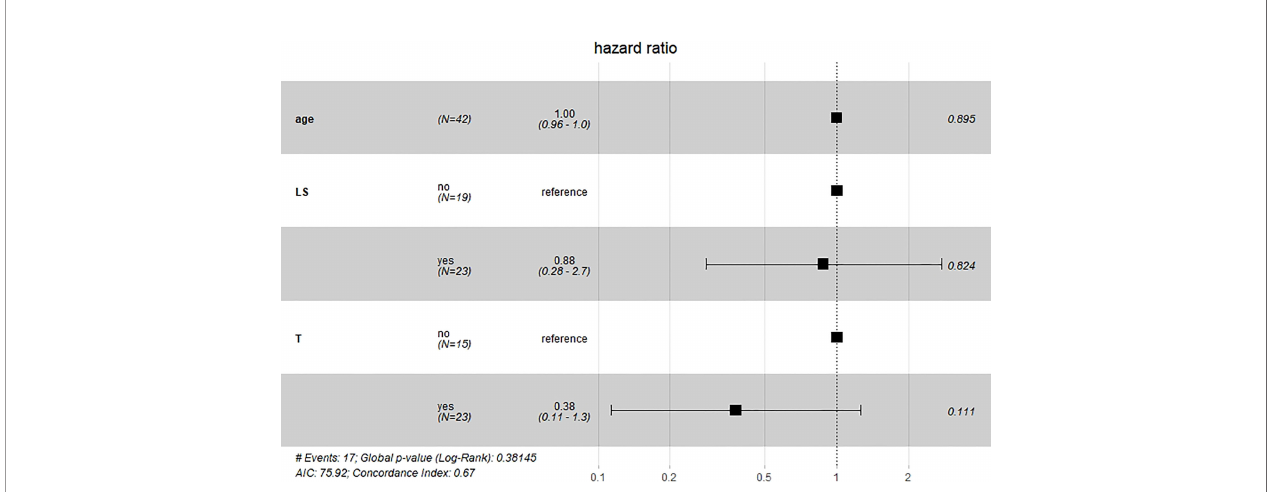
FIGURE 15 | Multivariate Cox hazard model analysis for TAH-based patients. Lymphadenectomy seems to have little effect, while complementary treatment reduces the risk of